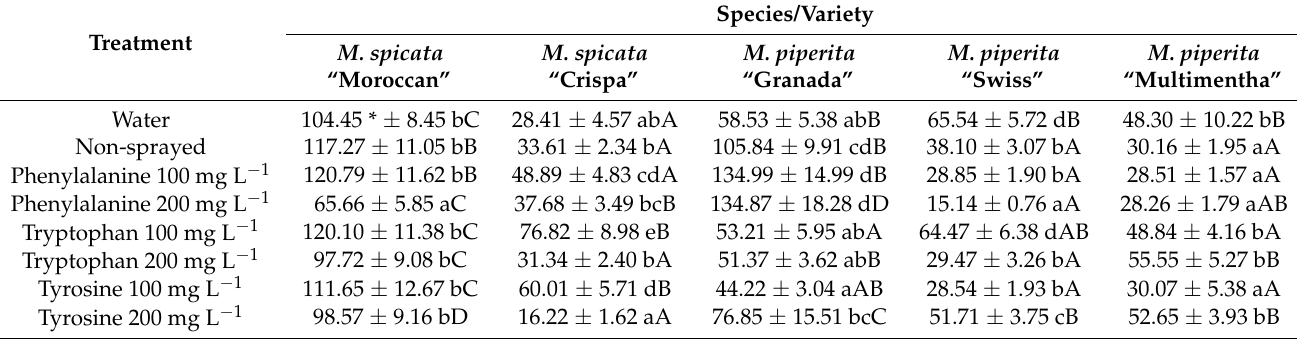
Table 5. p -coumaric acid content in mints influenced by foliar application of amino acids, mg 100 g − 1 DM in 2017–2018.